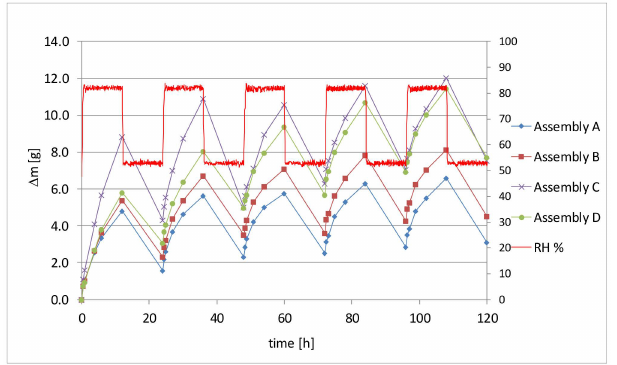
Figure 4. Measured changes in mass of individual assemblies during the adsorption and desorption phases.